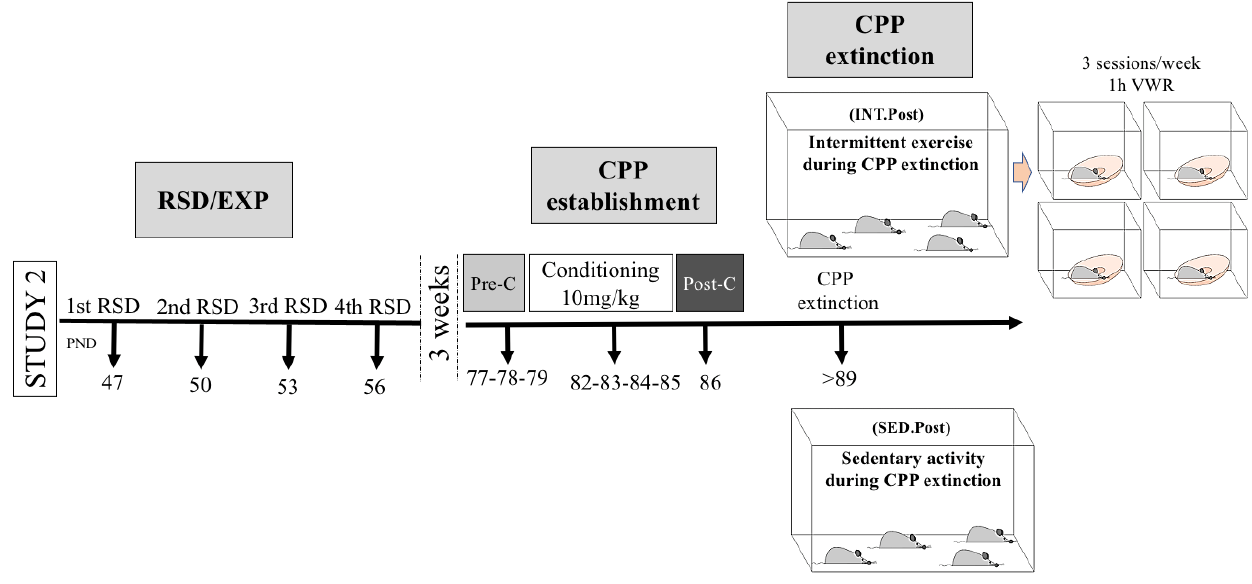
Figure 2. Experimental design and experimental groups of Study 2.